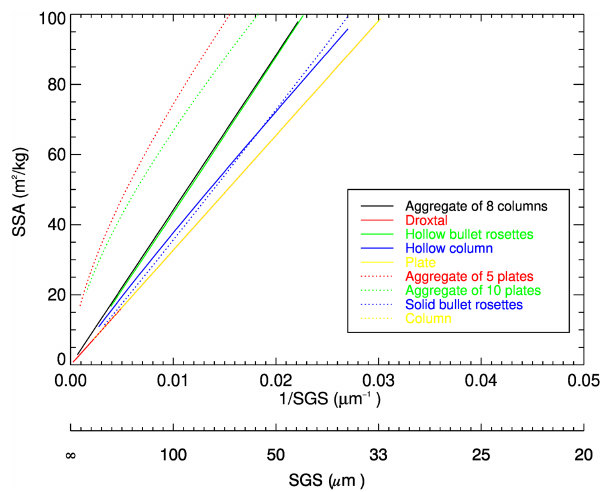
Figure 5. Relationship between SGS and SSA for different SPSs. For a better illustration, the realistic range of specific surface area is limited to 100m 2 kg − 1